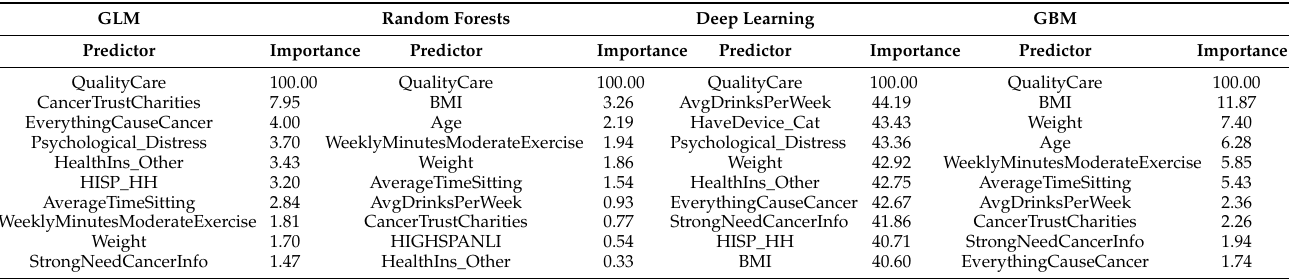
Table 2. Predictors of patient-centered communication built using GLM, Random Forests, Deep Learning, and GBM.